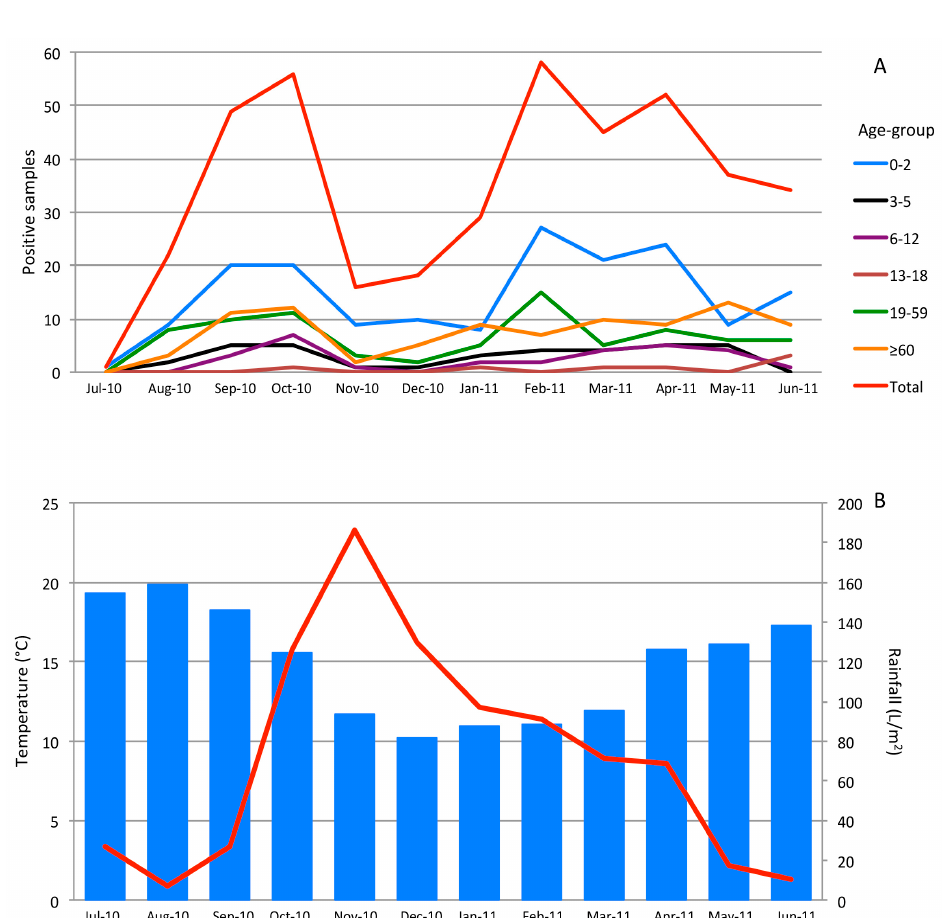
Figure 3. ( A ) Positive samples in the different age groups during the study. ( B ) Monthly rainfall (L/m 2 ) (line) and environmental temperatures (degrees Celsius) (bars), obtained from www.meteogalicia.es .